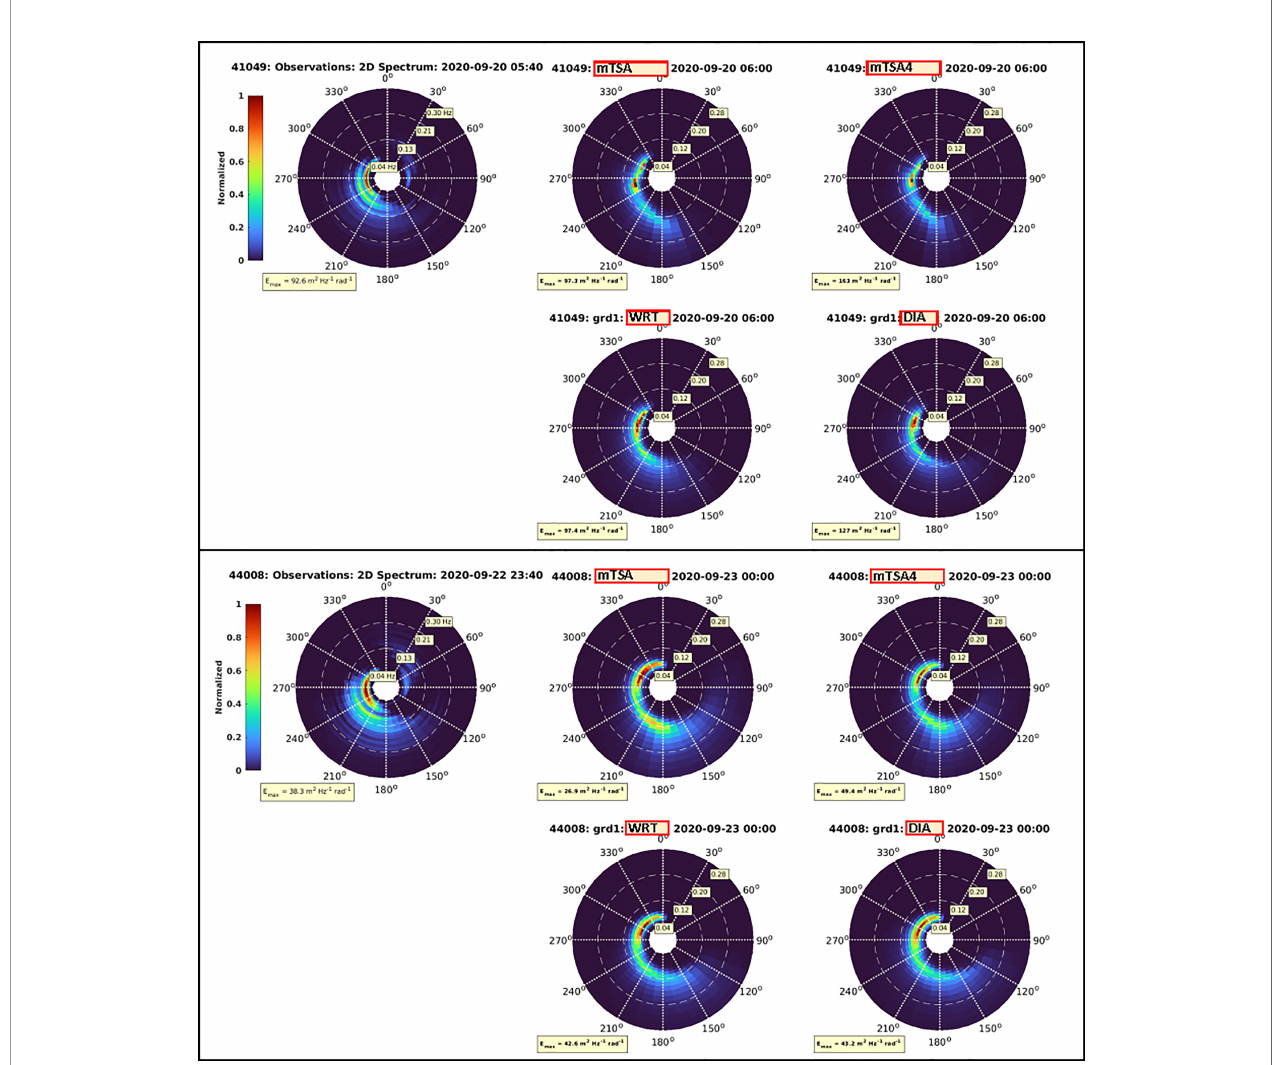
FIGURE 9 | As in Figure 7 for 2D spectrum for Hurricane Teddy at about the peak of the storm, 20 Sept 2020 at 5:40 UTC at buoy 41049, and 22 Sept 2020 at 23:49 UTS at buoy 44008, showing the observed spectrum compared to simulated results from WW3 with ST4 source terms, and DIA, WRT, mTSA4 for nonlinear wave-wave interactions S nl ( f , q ). Here, mTSA4 assumes the ST4 tuning from Perrie et al.